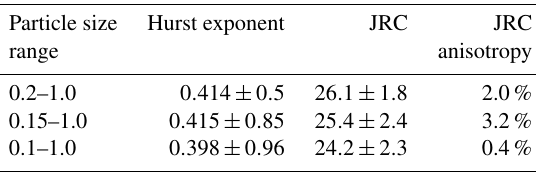
Table 1. Roughness properties for surfaces generated in numerical simulations of triaxial compression tests at σ 2 = 6MPa, σ 3 = 0 us- ing different particle size ranges for the DEM